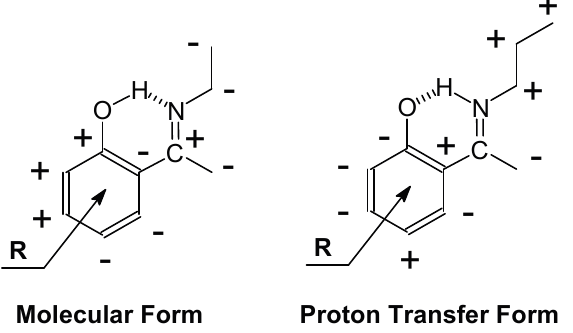
Figure 19. Deuterium isotope effect on 13 C chemical shift sign patterns of o -hydroxy Schiff bases.